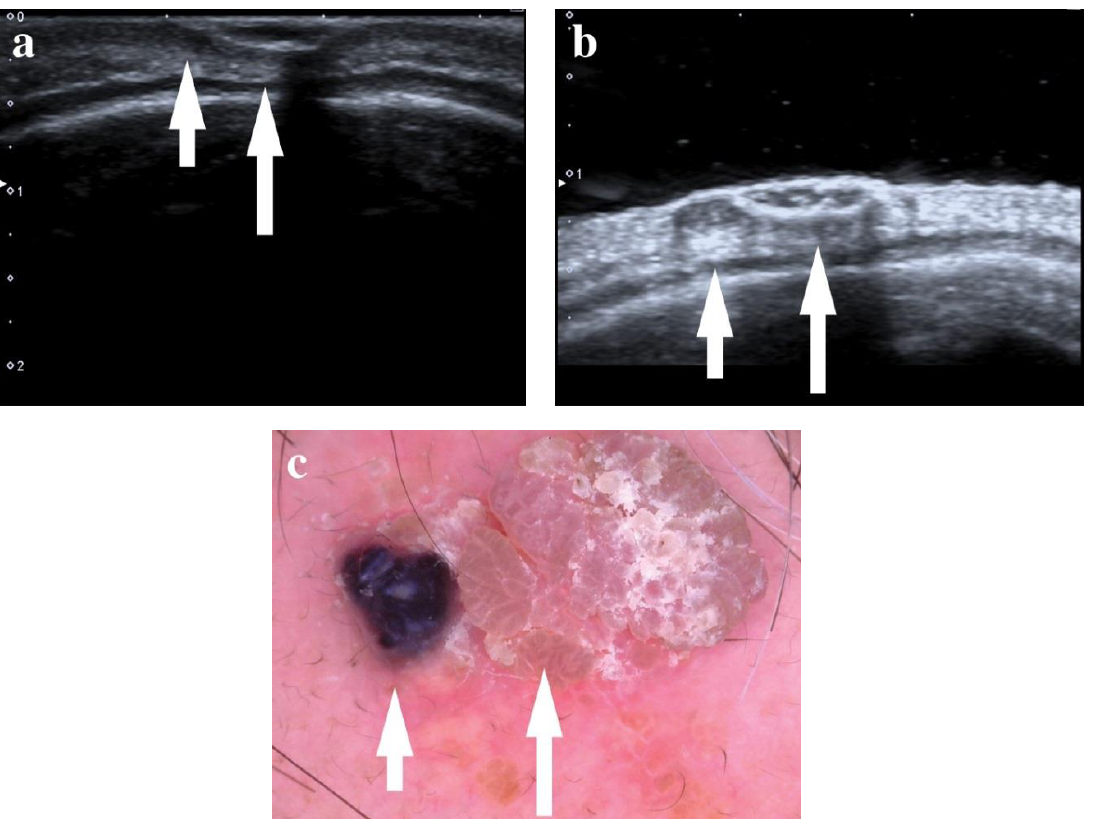
Figure 4. (a) Conventional ultrasound and (b) ultrasound with gel-pad of hemangioma with posterior enhancement (small white arrow) and keratosis with posterior shadowing (big white arrow). Ultrasound gel-pad provides an optimal possibility for revealing of different ultrasound acoustic phenomena. (c) Dermoscopy of the same cases: hemangioma (small black arrow) and keratosis (big black arrow) touching each